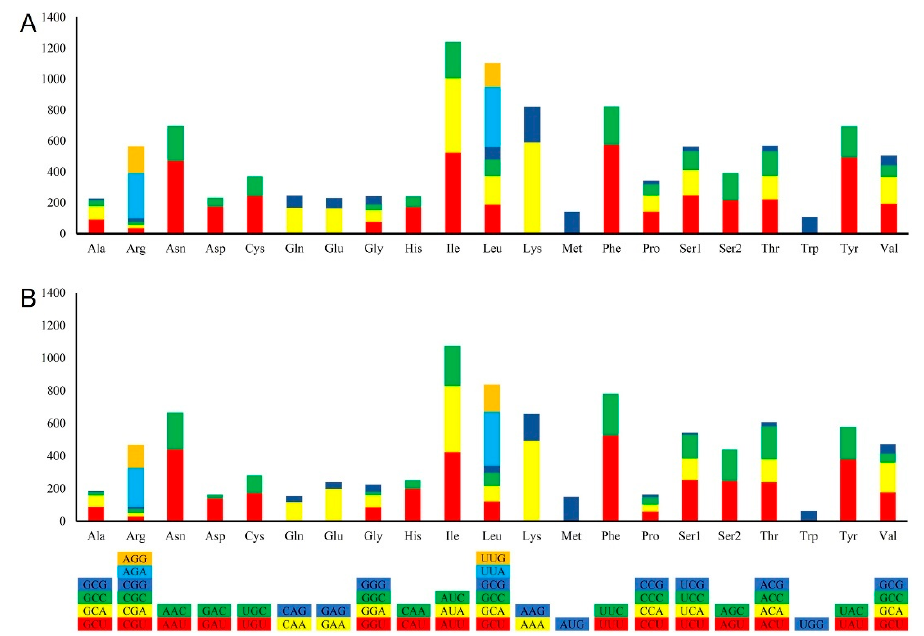
Figure 3. Mitochondrial genome codon usage in ( A ) C. trifolii and ( B ) L. chartarum . CodonW was used to analyze codon usage frequency for amino acids in these two genomes. Boxes with different colors represent different codon usage.